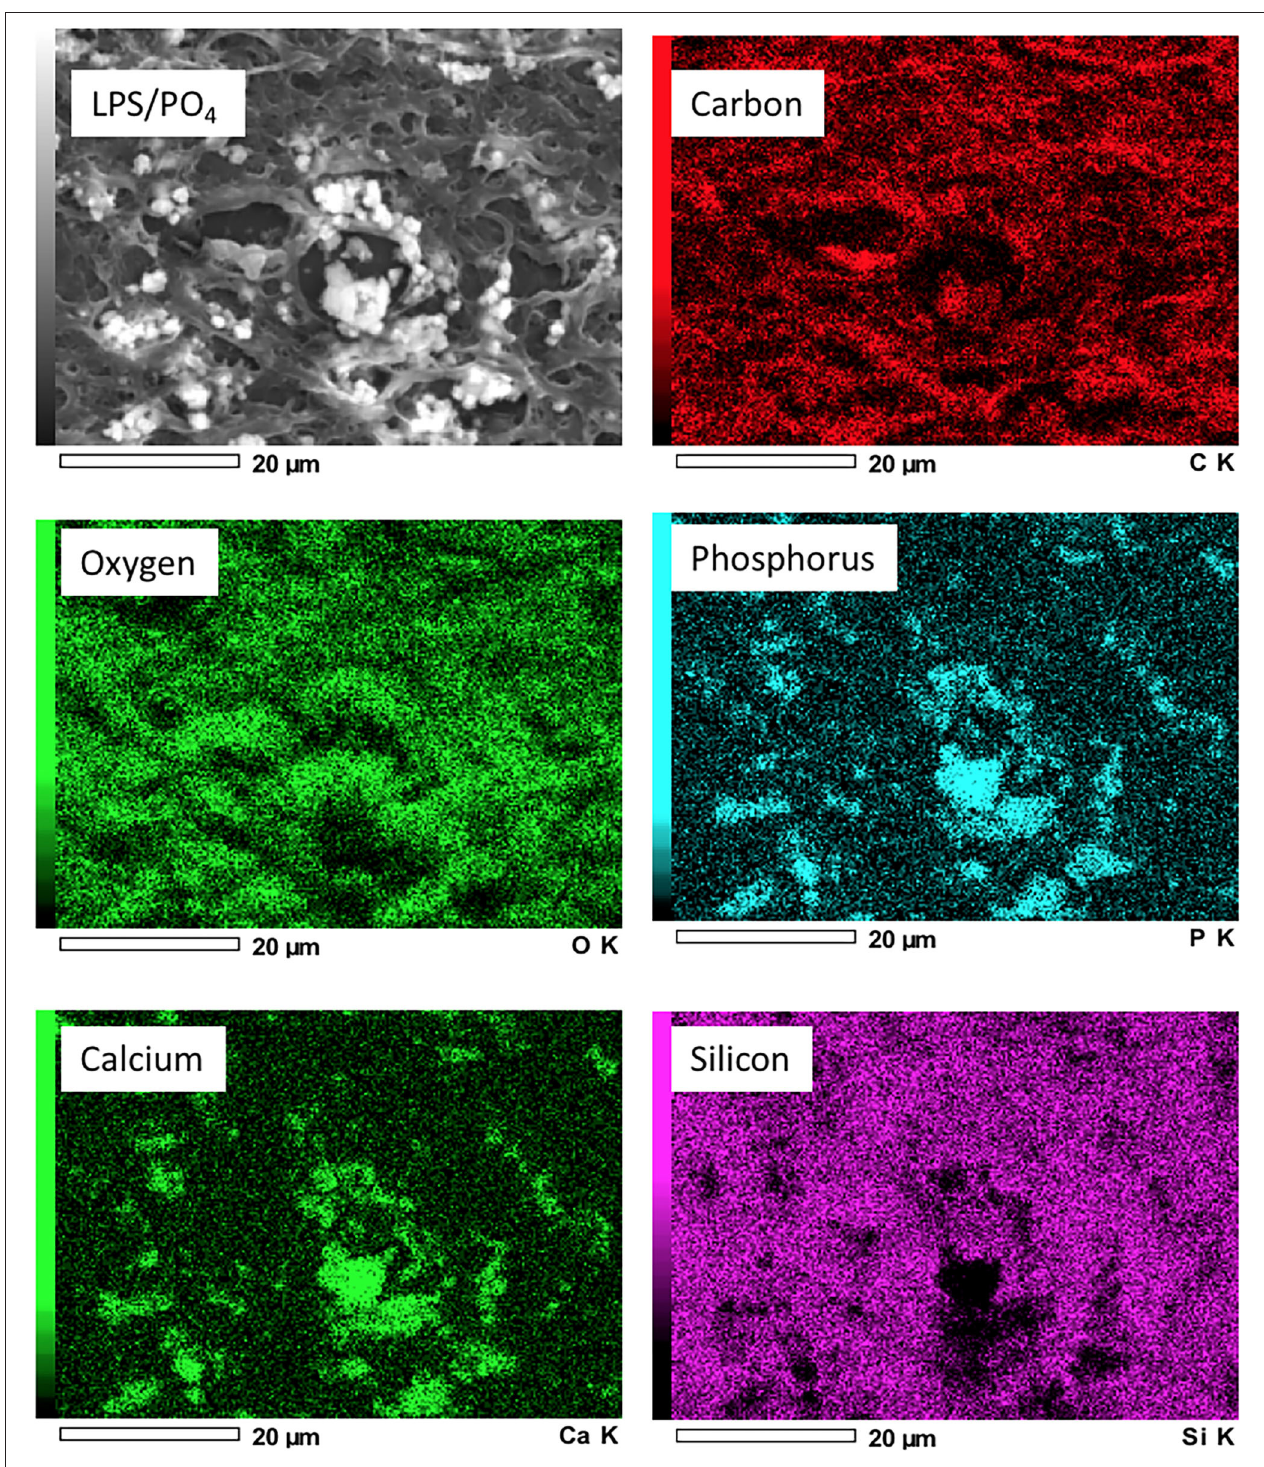
FIGURE 5 | Elemental mapping of LPS and phosphate treated valve leaflets. Scanning electron micrographs showing the elemental distribution of carbon, oxygen, phosphorus, calcium and silicon. Regions of greater electron density corresponding to the distribution of calcium and phosphorus.